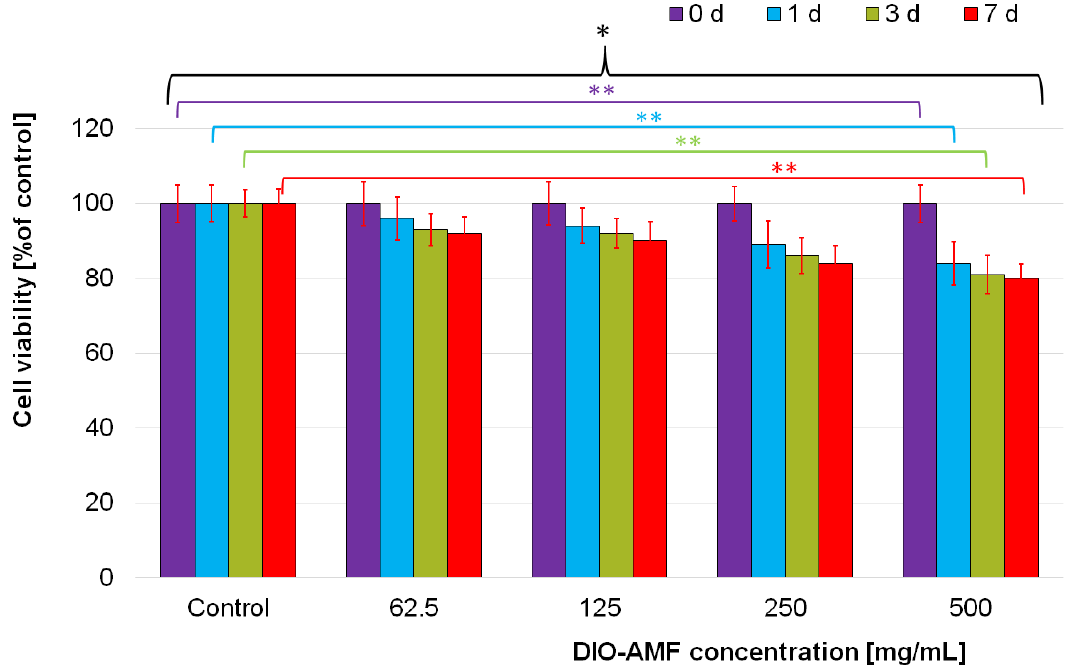
Figure 5. Graphical representation of the time dependent changes of HeLa cell viability in response to DIO-AMF. Cells incubated with 62.5, 125, 250 and 500 µ g/mL DIO-AMF for 0, 24 h, 72 h and 7 days. Cell viability analyzed by FDA staining and normalized to untreated control cells. The results are presented as mean ± SD. Statistical analysis was performed by one-way ANOVA. The p -values indicated are the following: * p ≤ 0.05, ** p ≤ 0.001.